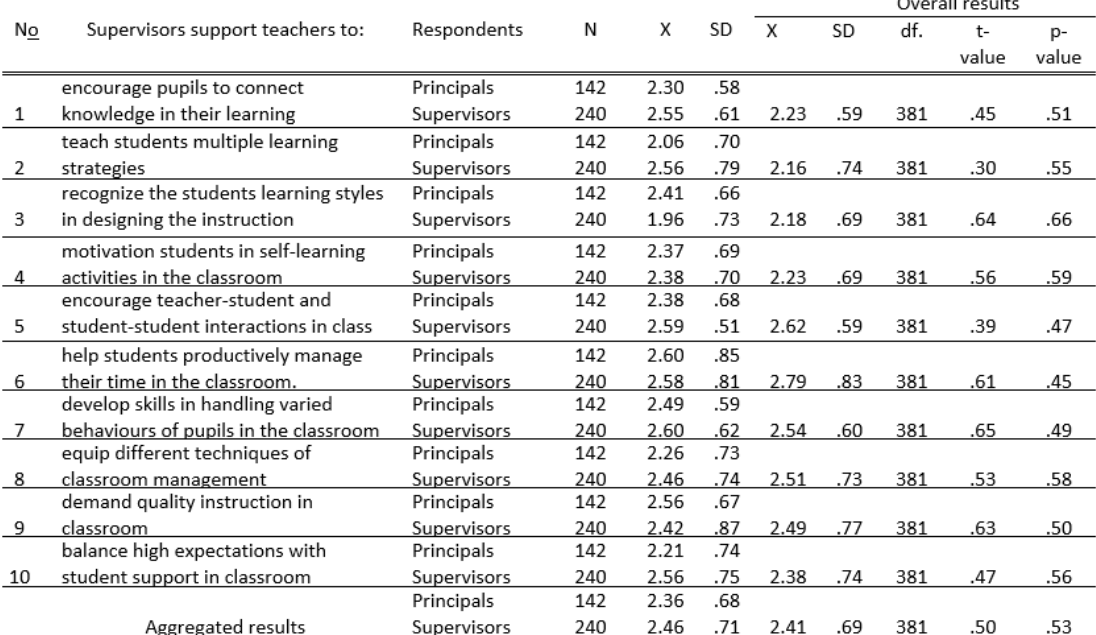
Table 1. Respondents’ views on supervisory support to teachers within the dimension of learning